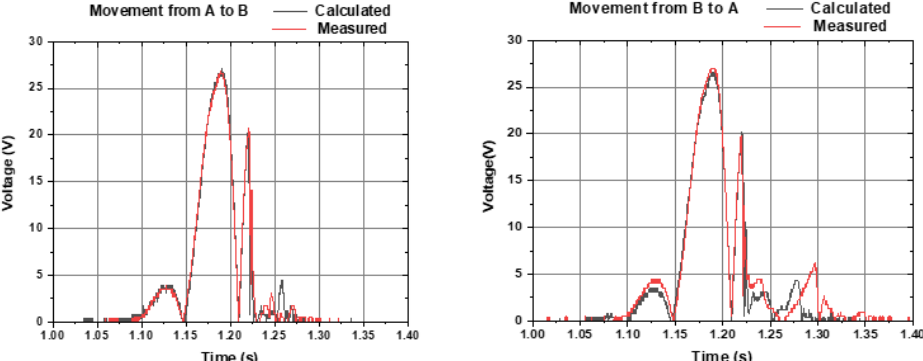
Figure 7. Calculated voltage (grey line) and experimentally measured voltage (red line) of the out ‐ put, within a freefall movement from Coil A to Coil B ( left graph ) and from Coil B to Coil A ( right graph ). Each coil voltage was connected in series and rectified.